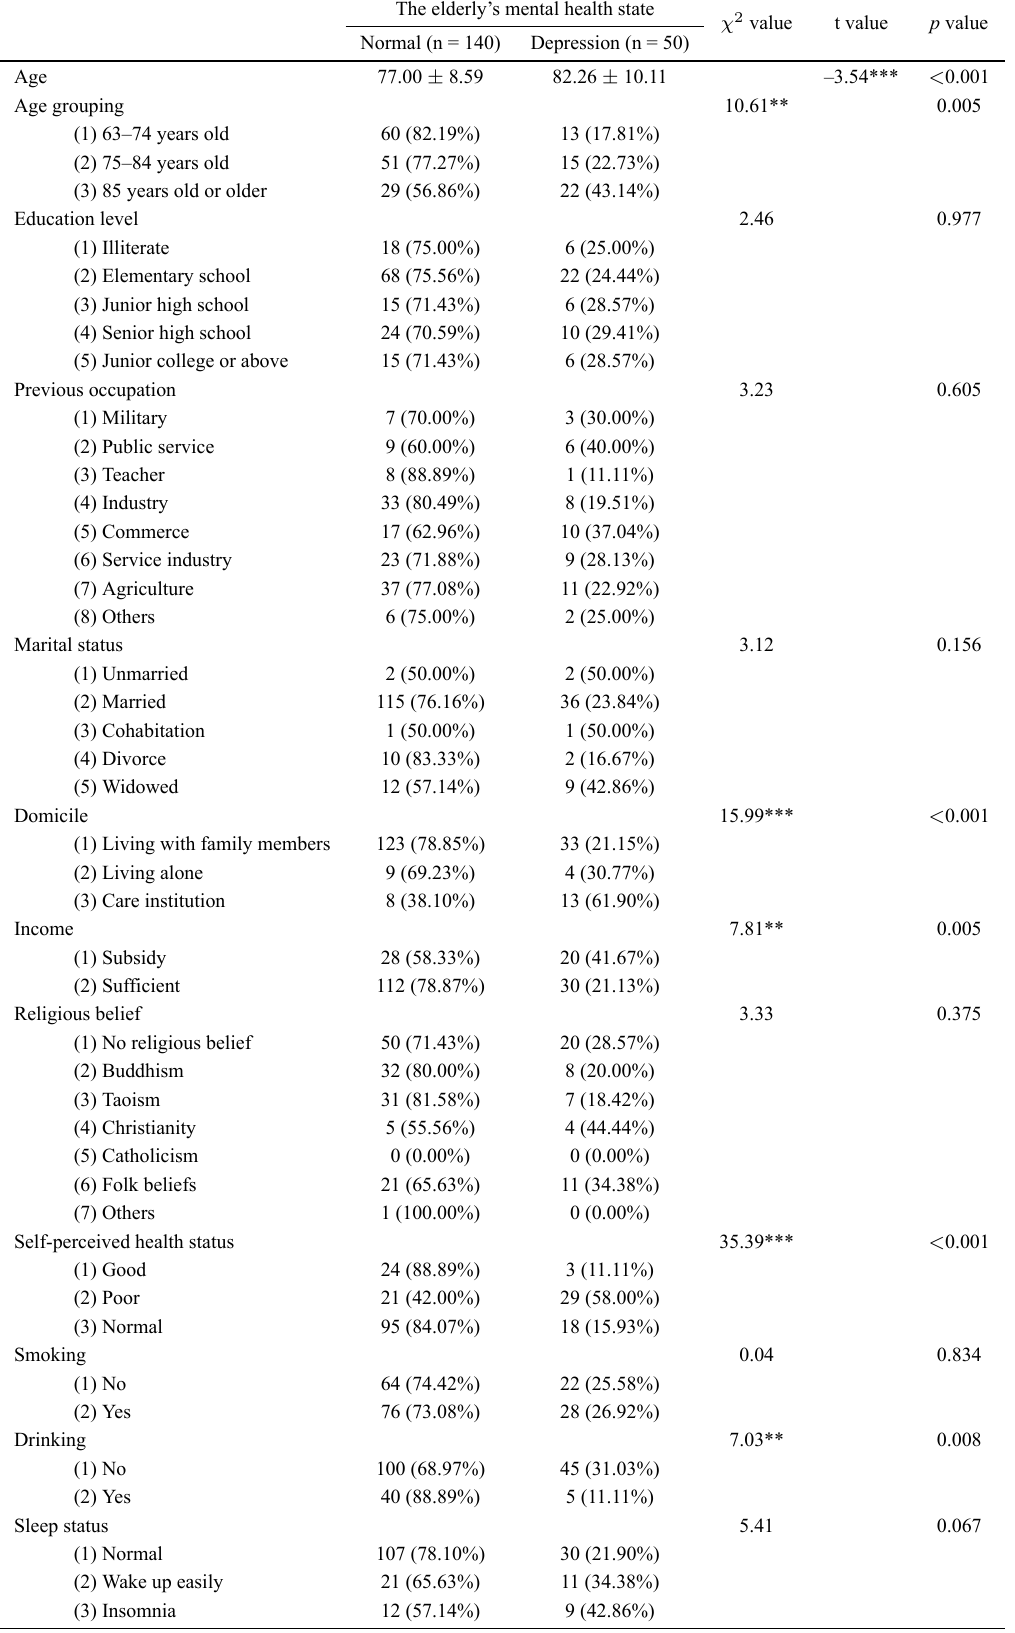
Table 2. Basic data, physical characteristics, cognitive function, community participation and mental health state of elderly men with